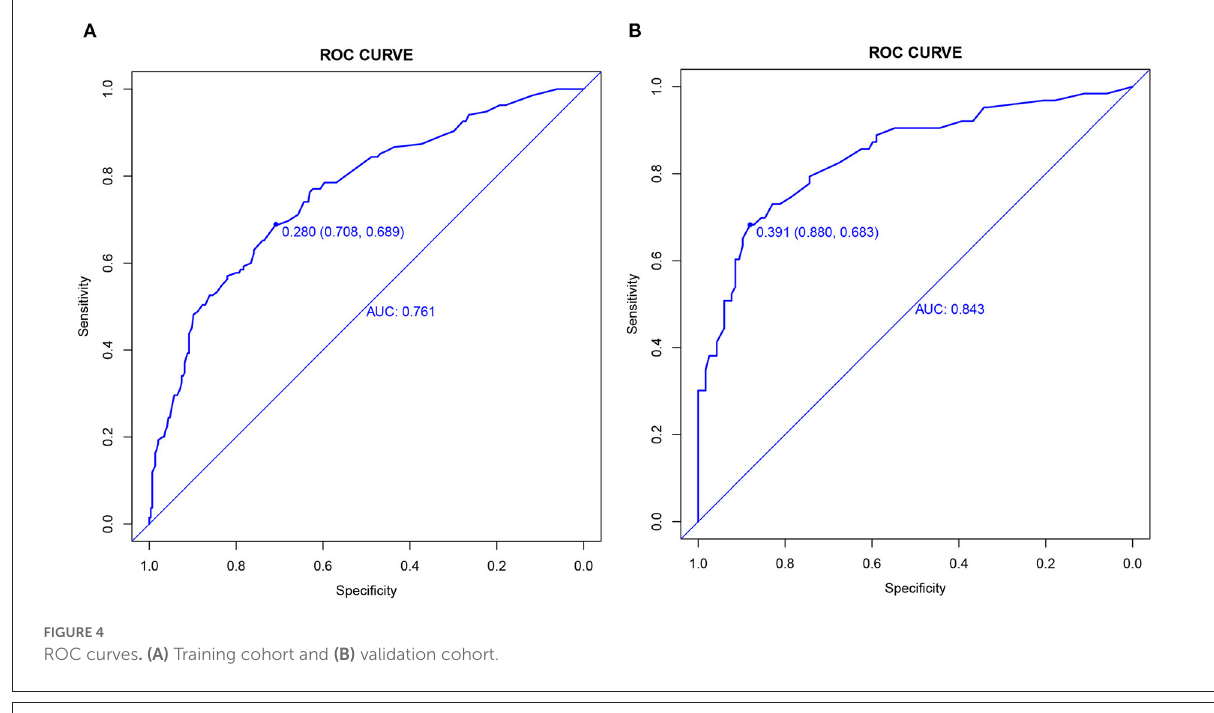
FIGURE4 ROC curves . (A) Training cohort and (B) validation cohort.